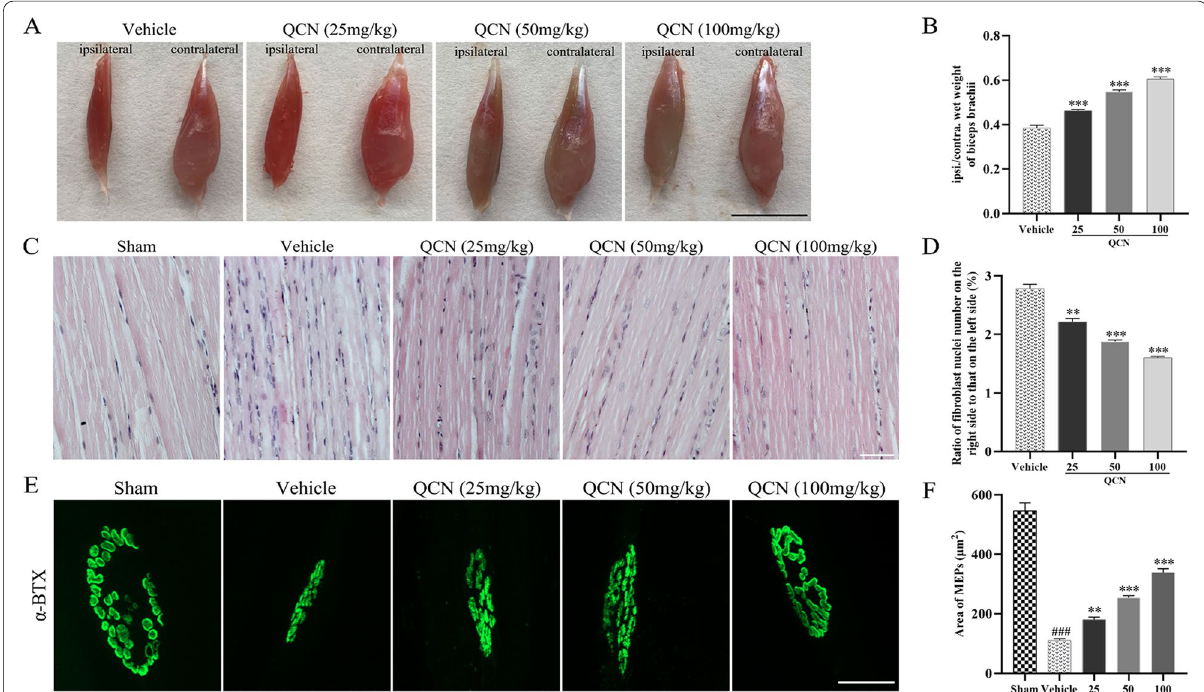
Fig. 4 Effects of QCN on muscle atrophy of the BPA rats at week 8 post‑avulsion. A Representative images of biceps muscles in both of the ipsilateral and contralateral sides. B The rate of wet weight of the biceps muscles. C Histological images of longitudinal bicep sections with H & E staining. D The percentage of fibroblast nuclei number in the ipsilateral to contralateral biceps. E Representative Z‑Stack images of biceps muscles sections stained with FITC‑conjugated α‑BTX. F Average area of MEPs in each group. Data are expressed as the mean the sham group; ** p < 0.01 and *** p < 0.001 vs the vehicle group. Scale bar 1 cm in A, 50 μm in C , 20 μm in